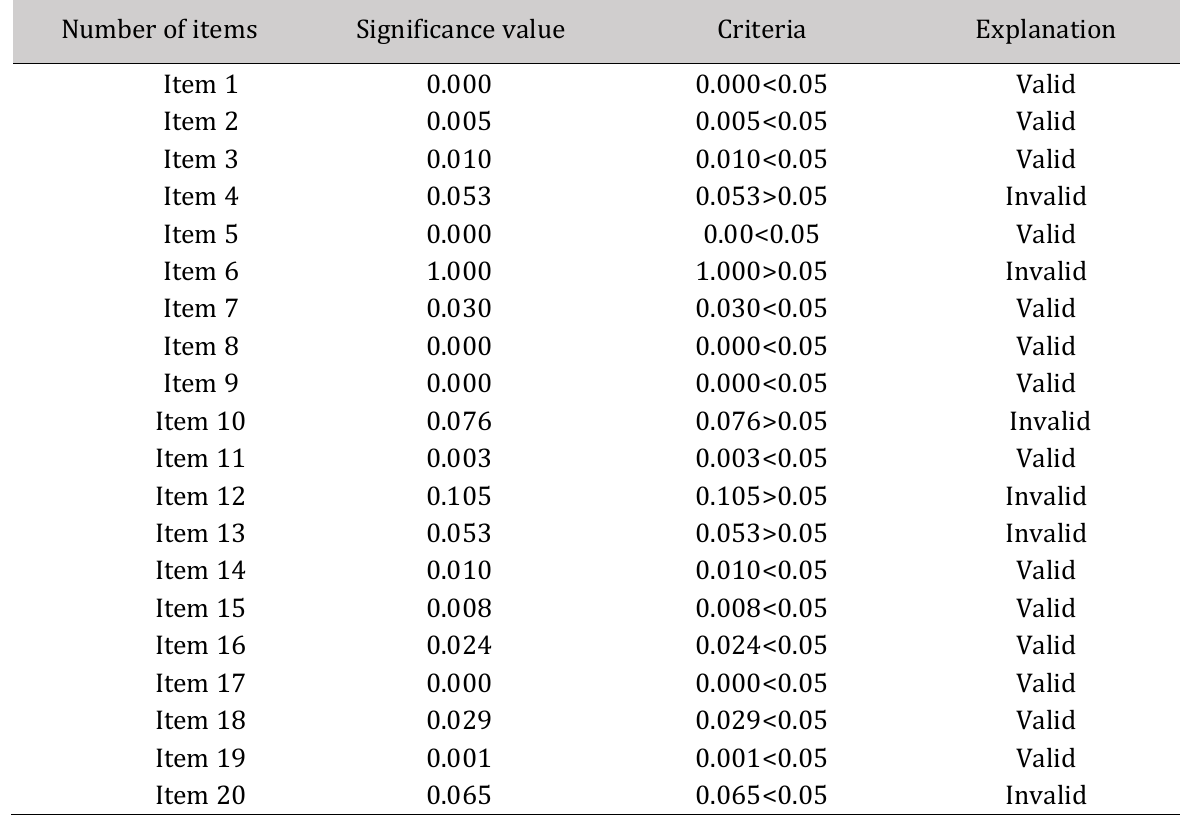
Table 4. The validity test of the teacher’s oral